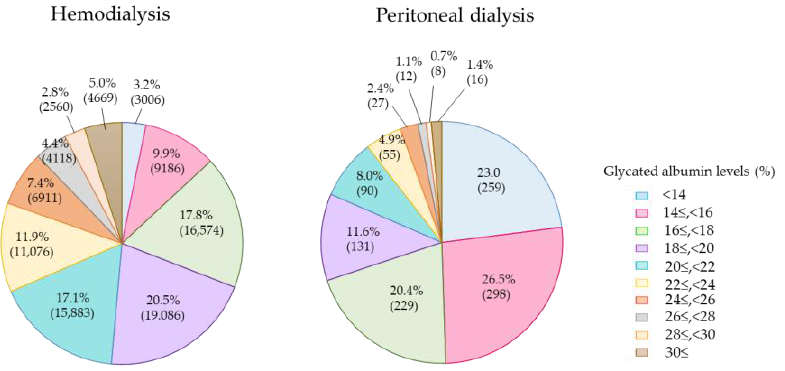
Figure 3. Glycated albumin (GA) levels of diabetes patients on hemodialysis and peritoneal dialysis in 2018.